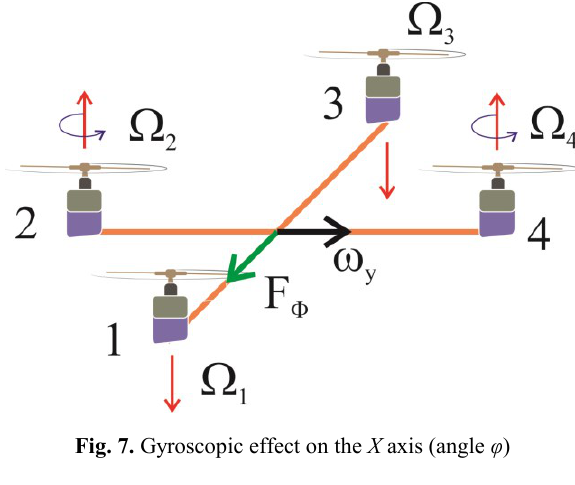
Fig. 7. Gyroscopic effect on the X axis (angle φ )